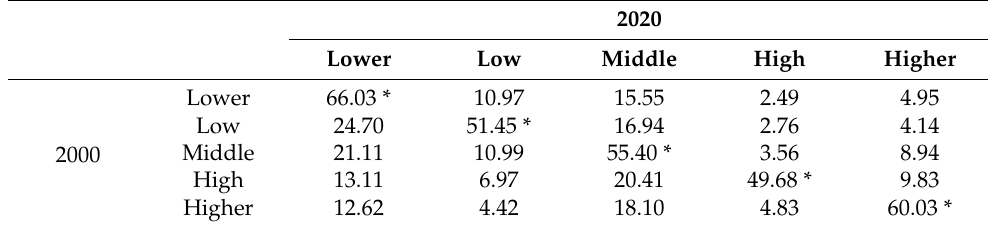
Table 11. Habitat quality grade transfer matrix between 2000 to 2020